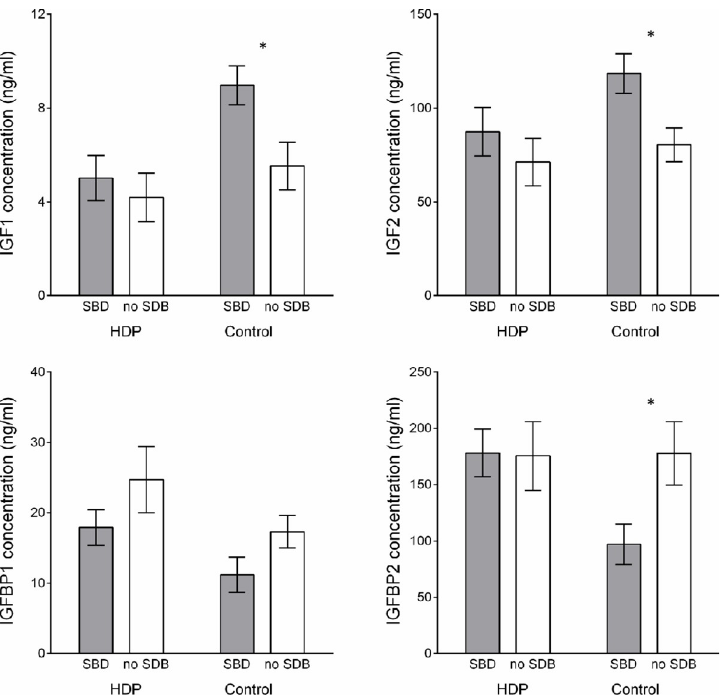
Fig 2. Mean ± SEM insulin-like growth factor 1 and 2 (IGF-1, IGF-2) and insulin-like growth factor binding protein 1 and 2 (IGFBP-1, IGFBP 2) for the SDB vs. No SDB group within the HDP and control group ( � p value = .02). HDP group–SDB n = 17, No SDB n = 13. Control group SDB n = 8, No SDB n = 17, except for IGFBP-1 where HDP group–No SDB n = 12, Control group No SDB n = 16. SDB = sleep-disordered breathing, HDP = hypertensive disorders of